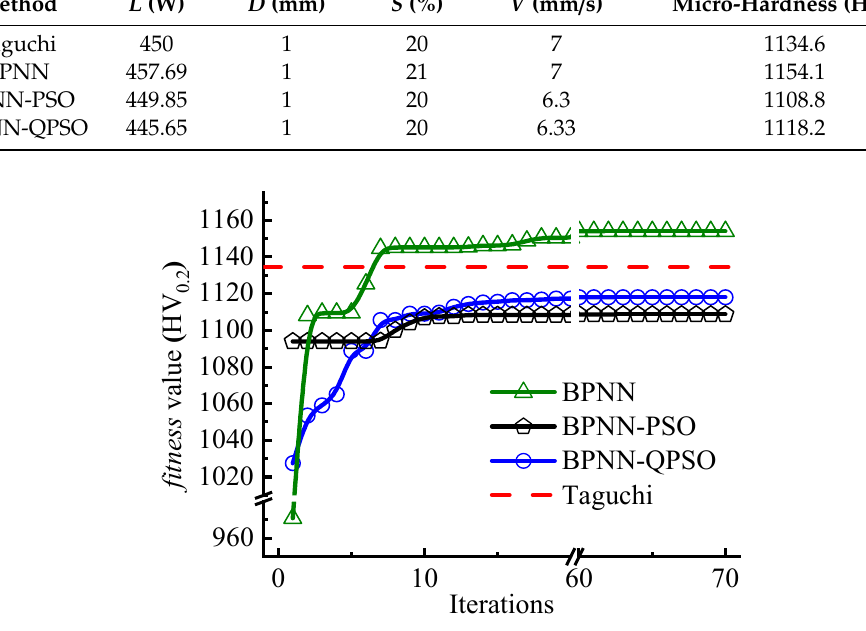
Figure 13. Fitness value iteration of coating micro-hardness.